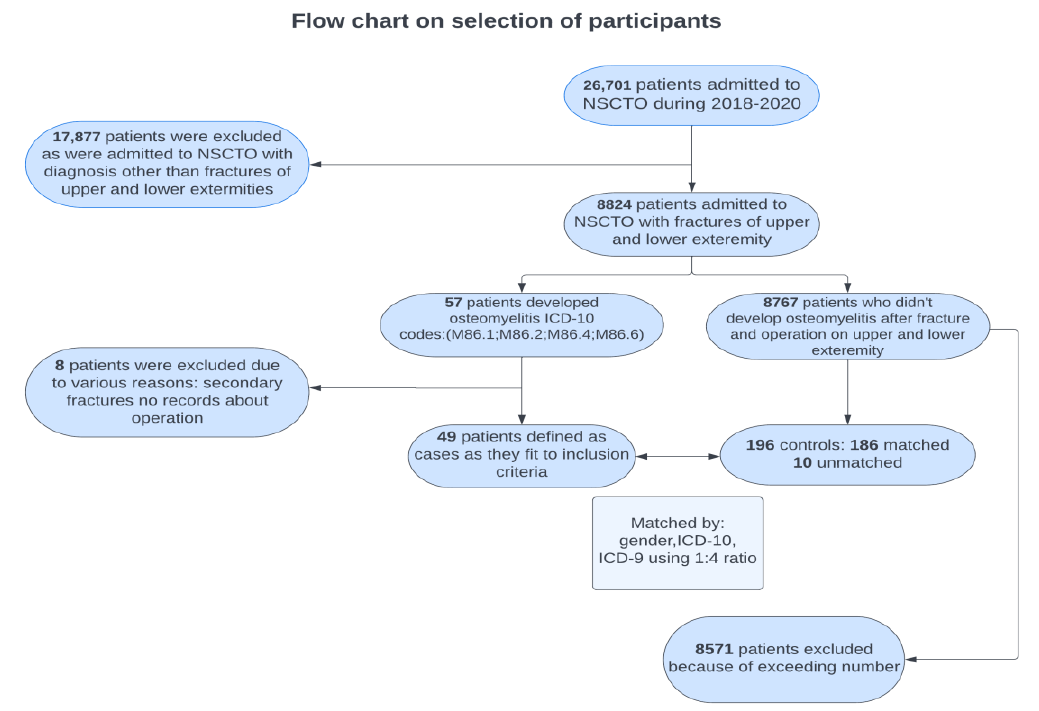
Figure 1. Patient flow chart.